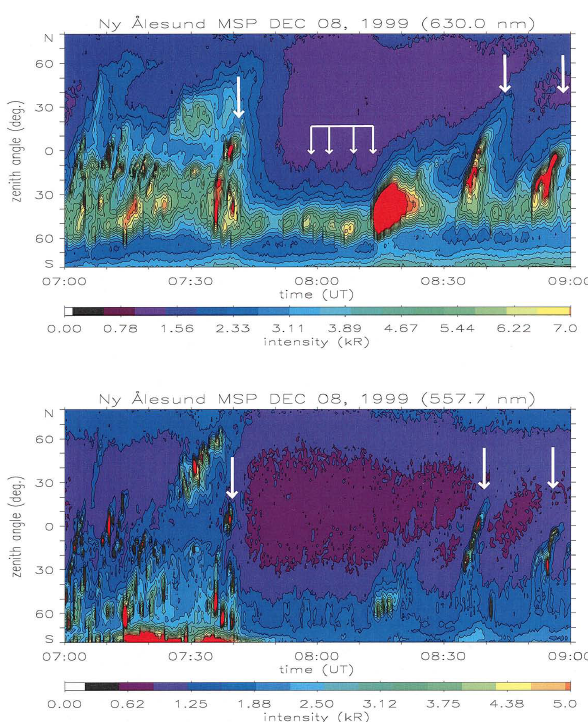
Fig. 5. MSP observations of auroral configuration around mag- netic noon on 8 December 1999. Line-of-sight intensities are shown as a function of zenith angle for the red (top panel) and green oxygen lines at 630.0 and 557.7nm. North is up. PMAF/prenoon (07:40UT) and PMAFs/postnoon (08:30–09:00UT) are marked by